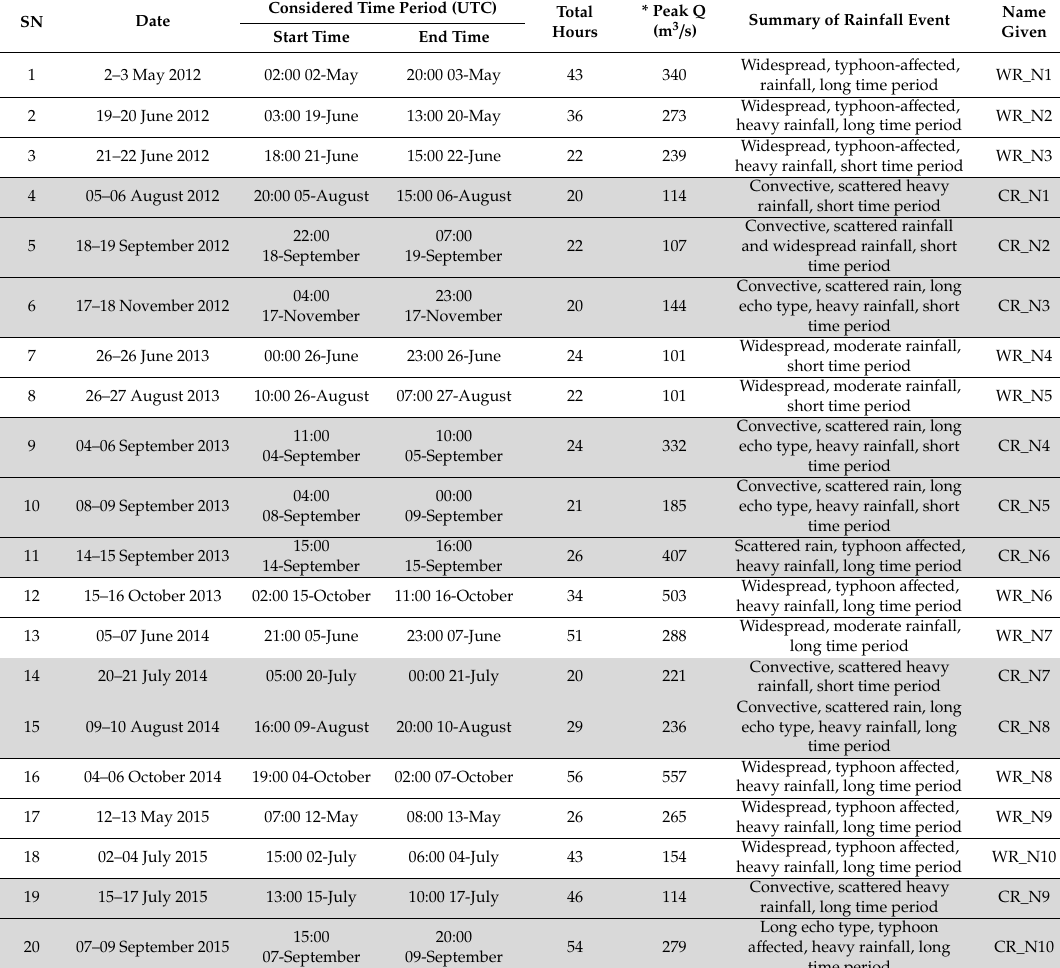
Table 1. Dates, durations, peak discharge, and summary of selected rainfall